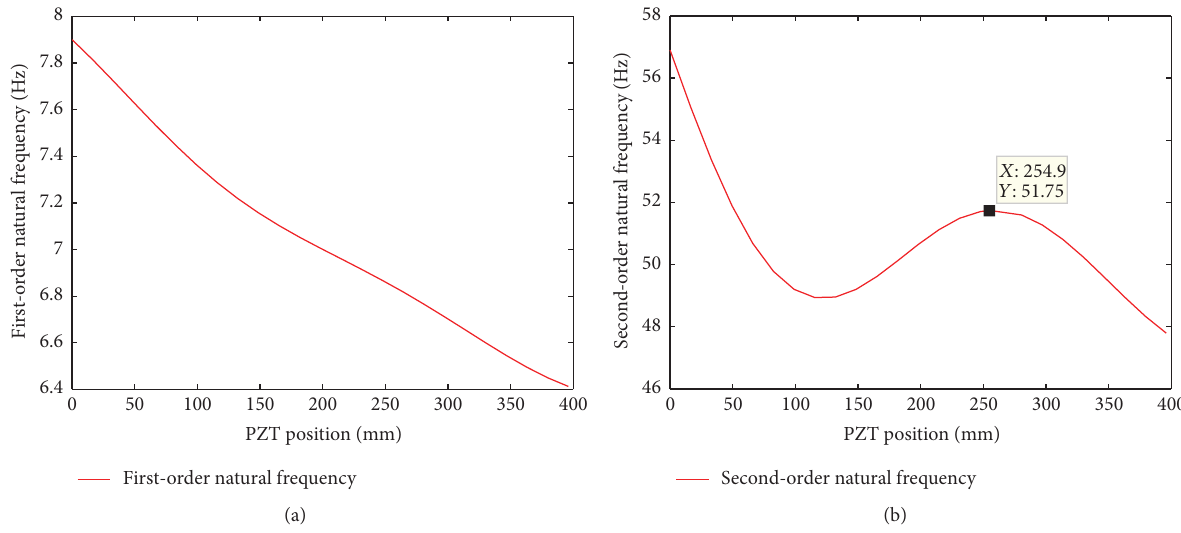
Figure 10: Changing trends of natural frequencies along with the position of piezoelectric actuator ((a) first-order natural frequency; (b) second-order natural